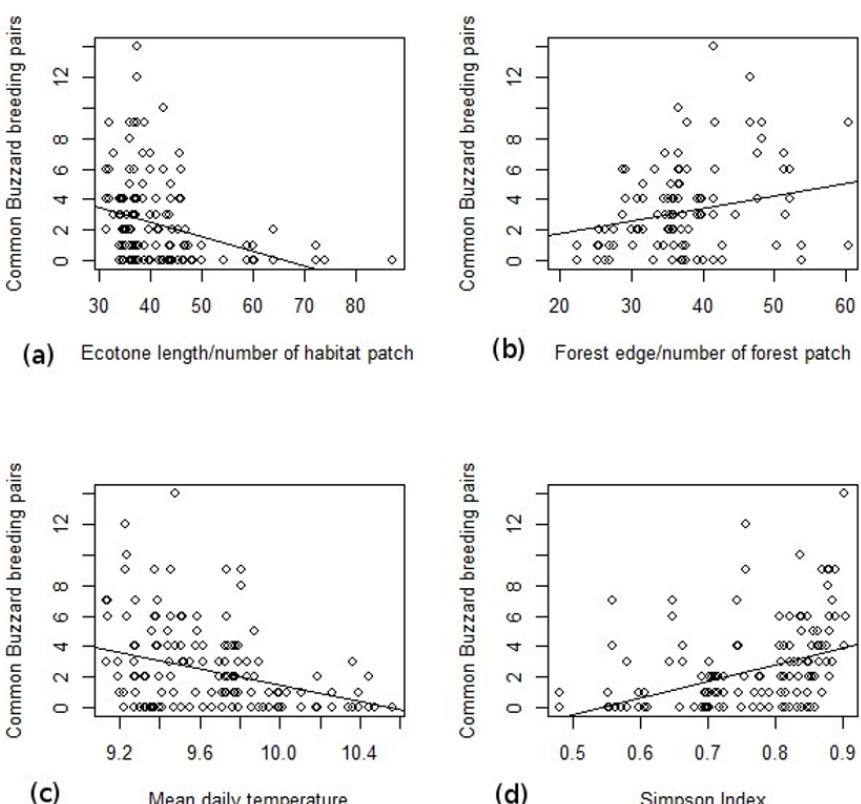
Figure 2. The relationship between Common Buzzard breeding pairs on each surveyed square and the influencing factors during the 2011 and 2012 breeding seasons. ( a ) the relationship between Common Buzzard breeding pairs and Ecotone length/number of habitat patch, ( b ) the relationship between Common Buzzard breeding pairs and Forest edge/number of forest patch, ( c ) the relationship between Common Buzzard breeding pairs and Mean daily temperature, ( d ) the relationship between Common Buzzard breeding pairs and Simpson